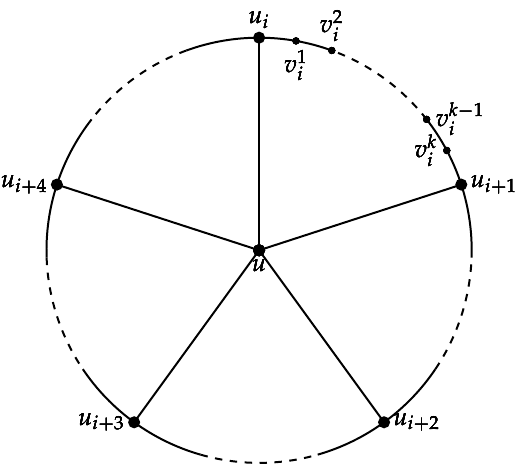
Figure 1. Generalized Jahangir graph J 5, k